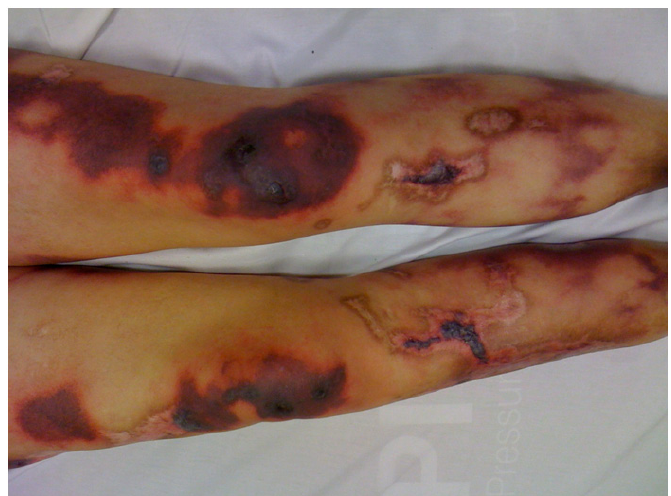
Figure 2. Retiform purpuric skin lesions with eschar on lower